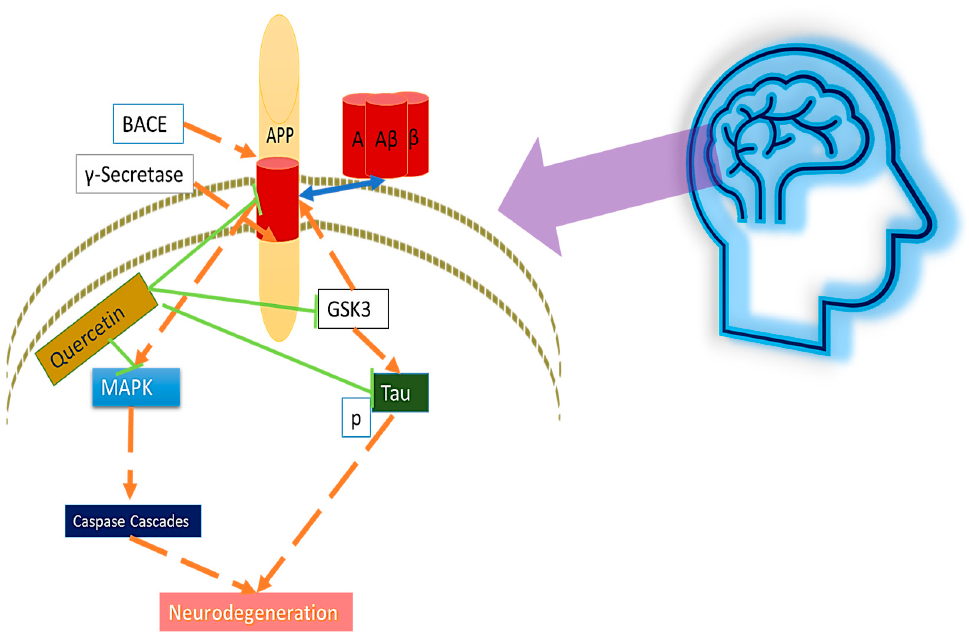
Figure 1. The effects of quercetin on amyloid beta and tauopathy of neurodegeneration.